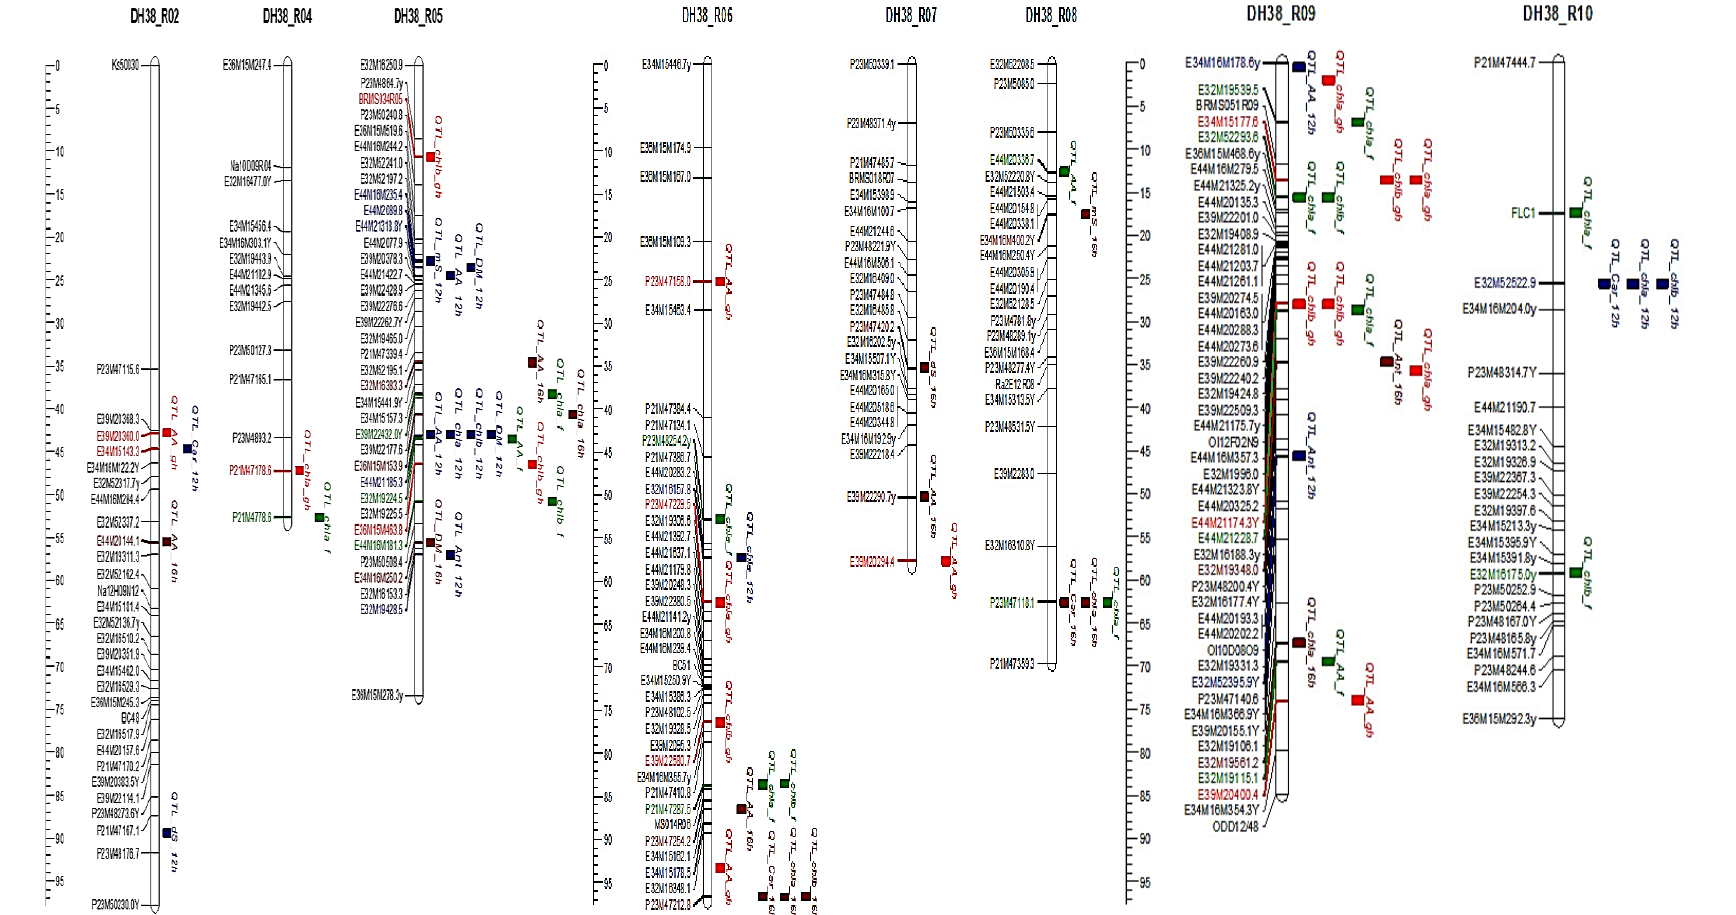
Figure 4. Mapping of QTLs determining expression of biochemical traits of in Brassica rapa L. (DH 38): 12h – AFI experiment, light culture 12 hours, 16h – AFI experiment, light culture 16 hours; gh – VIR experiment, greenhouse, f – VIR experiment, field. Traits designations: AA – ascorbic acid, Car – carotenoids, chla – chlorophyll a , chlb – chlorophyll b , DM – dry matter, mS – monosaccharides, dS – disaccharides.